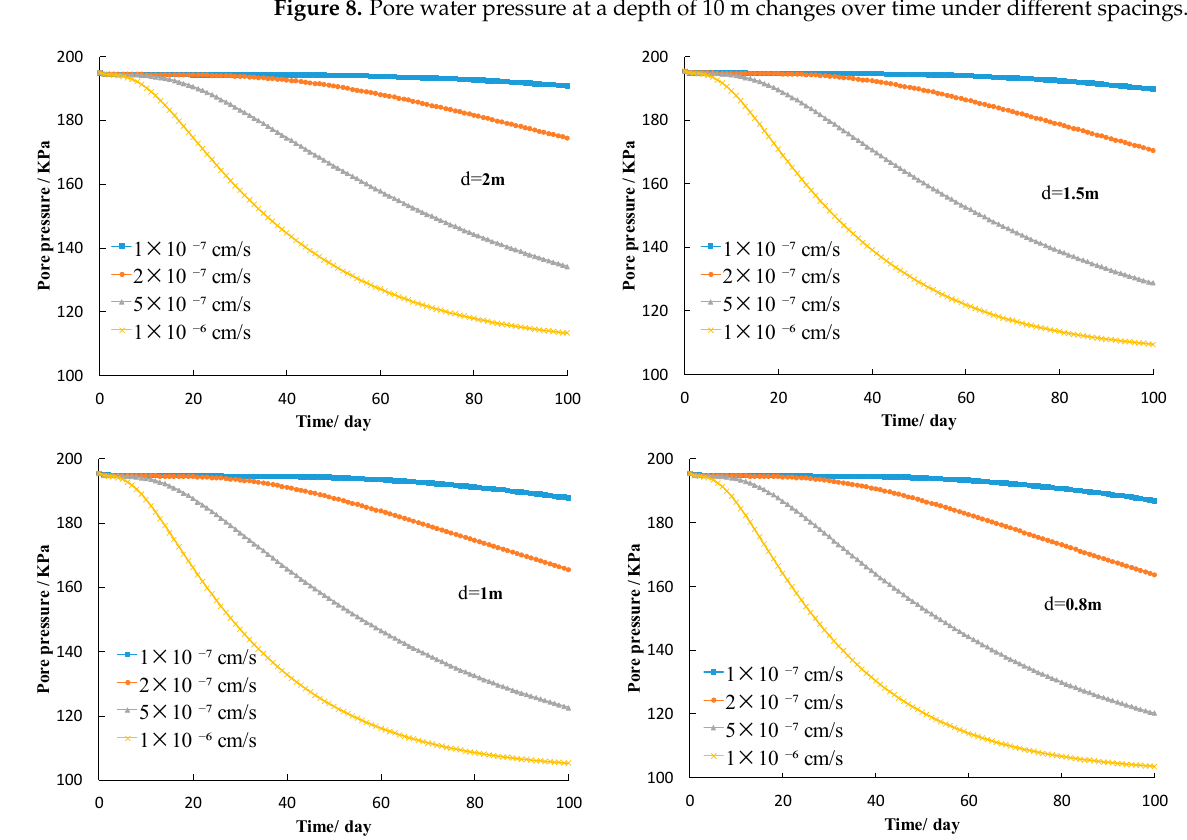
Figure 9. Pore water pressure at a depth of 20 m at the corner of the square column changes over time.